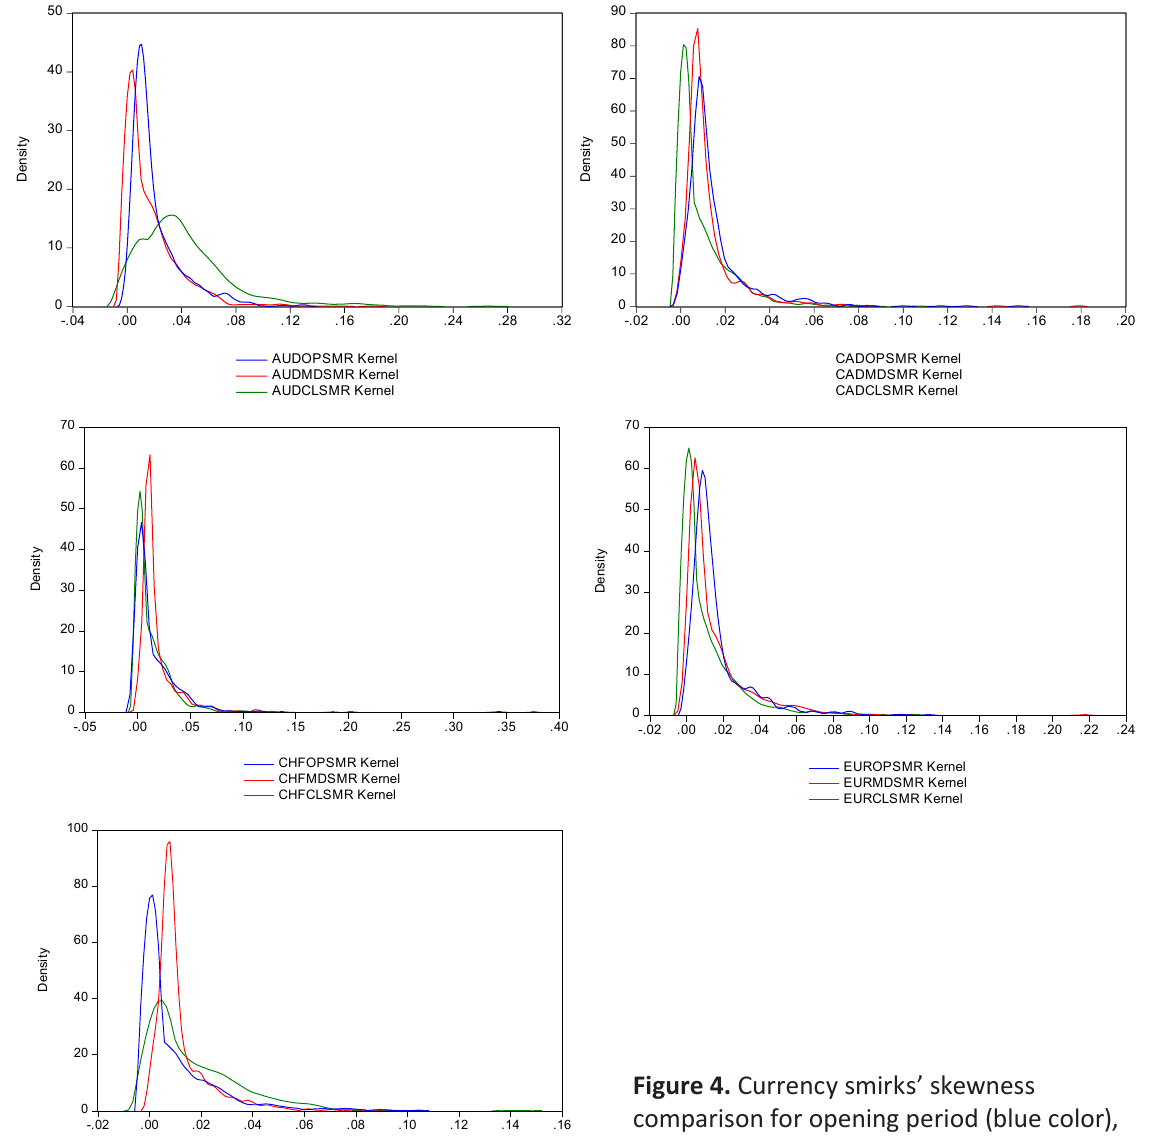
Figure 4. Currency smirks’ skewness comparison for opening period (blue color), midday period (red color) and closing period (green